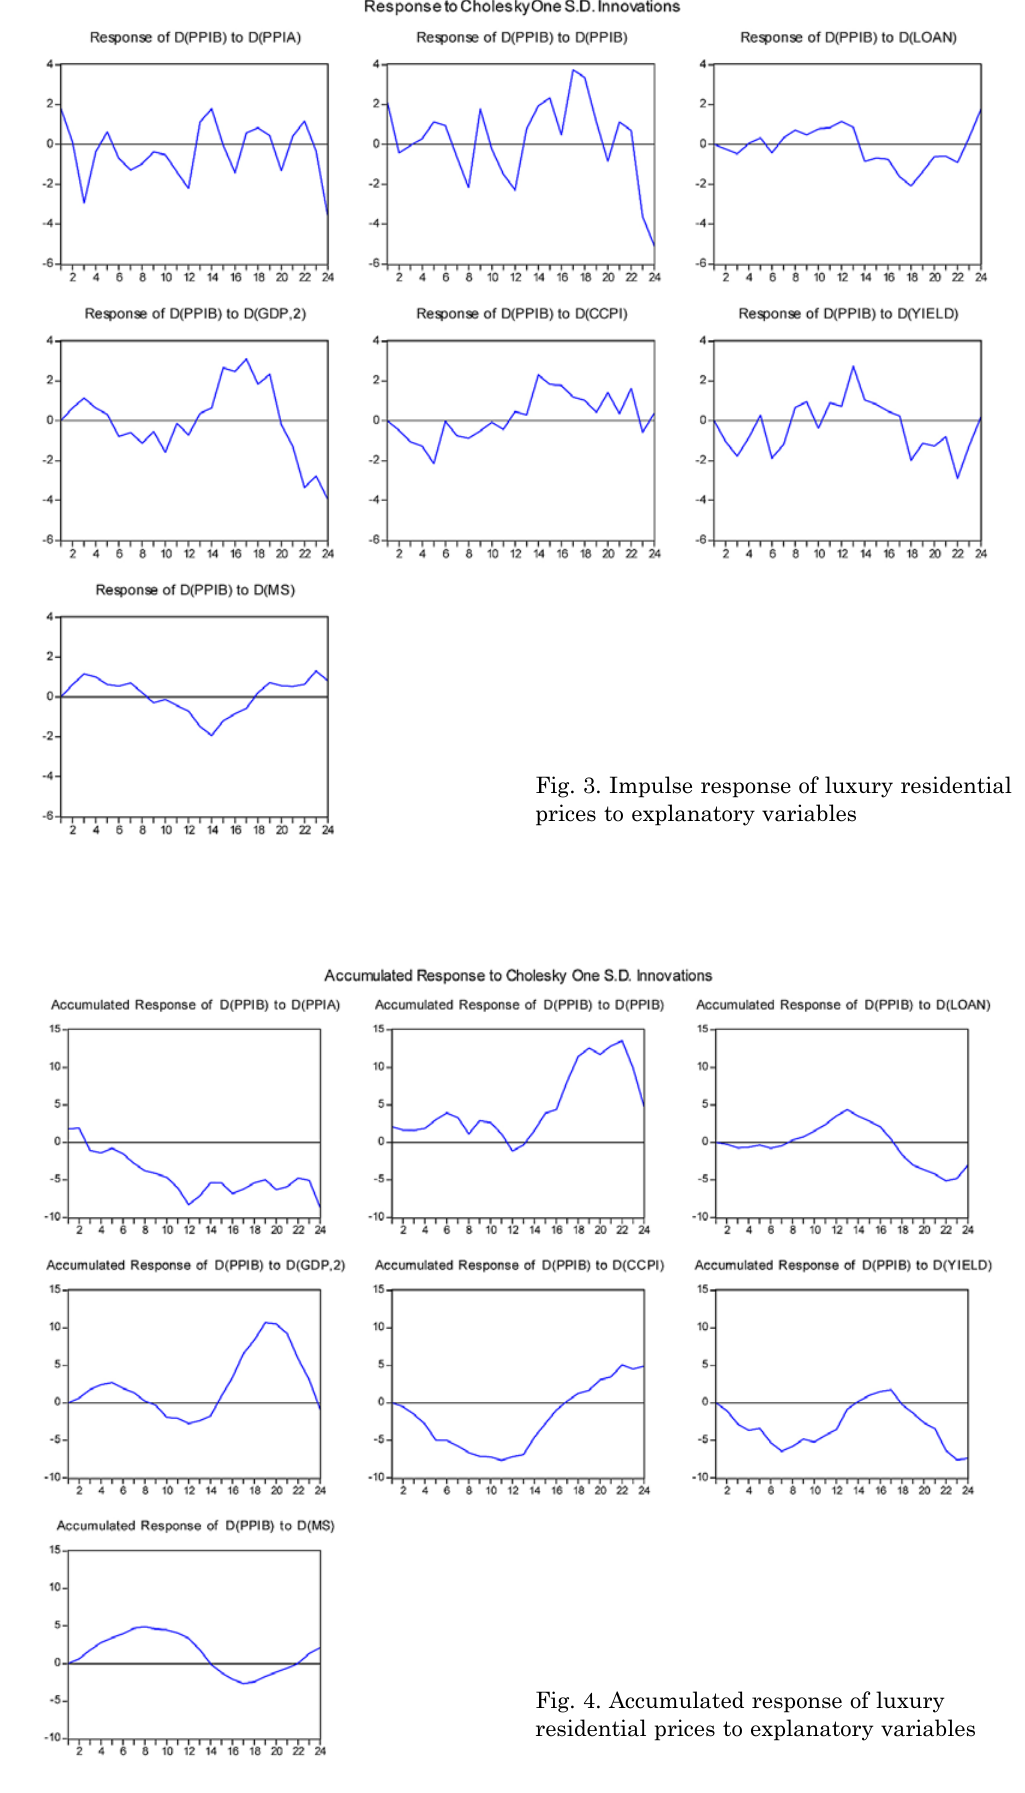
Fig. 4. Accumulated response of luxury residential prices to explanatory